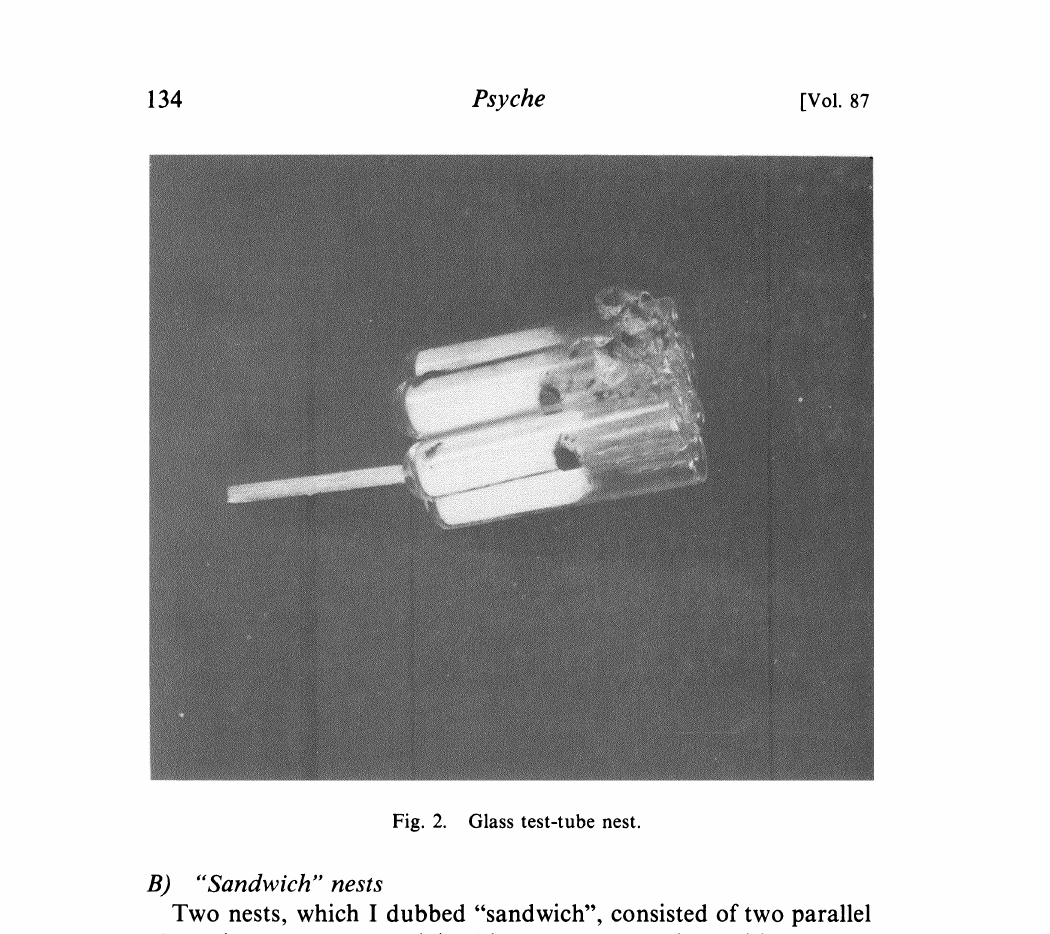
Fig. 2. Glass test-tube